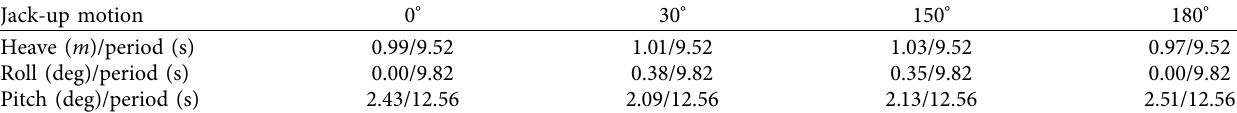
Table 4: Maximum motion responses at T